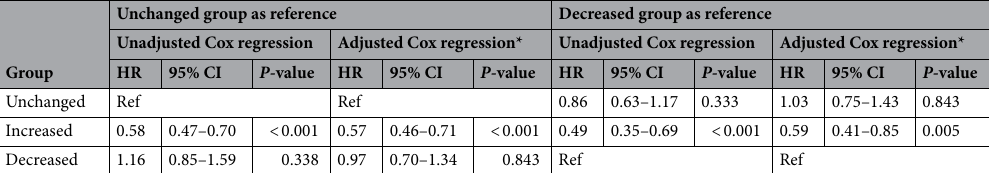
Table 2. Unadjusted and adjusted Cox regression for combined endpoint. *Adjusted for age, male sex, New York Heart Association functional class III/IV, history of hypertension, diabetes, atrial fibrillation, systolic blood pressure at discharge, serum albumin, hemoglobin, creatinine, sodium, potassium, and log-transformed BNP measured at the time of discharge; prescription of ACEi/ARB, BB, and MRA at discharge.